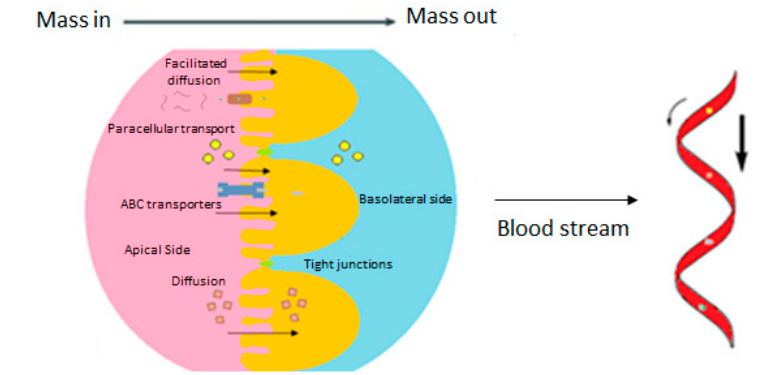
Figure 1. Representation of the structure of the intestinal membrane showing the different routes of drug and nutrient transport.